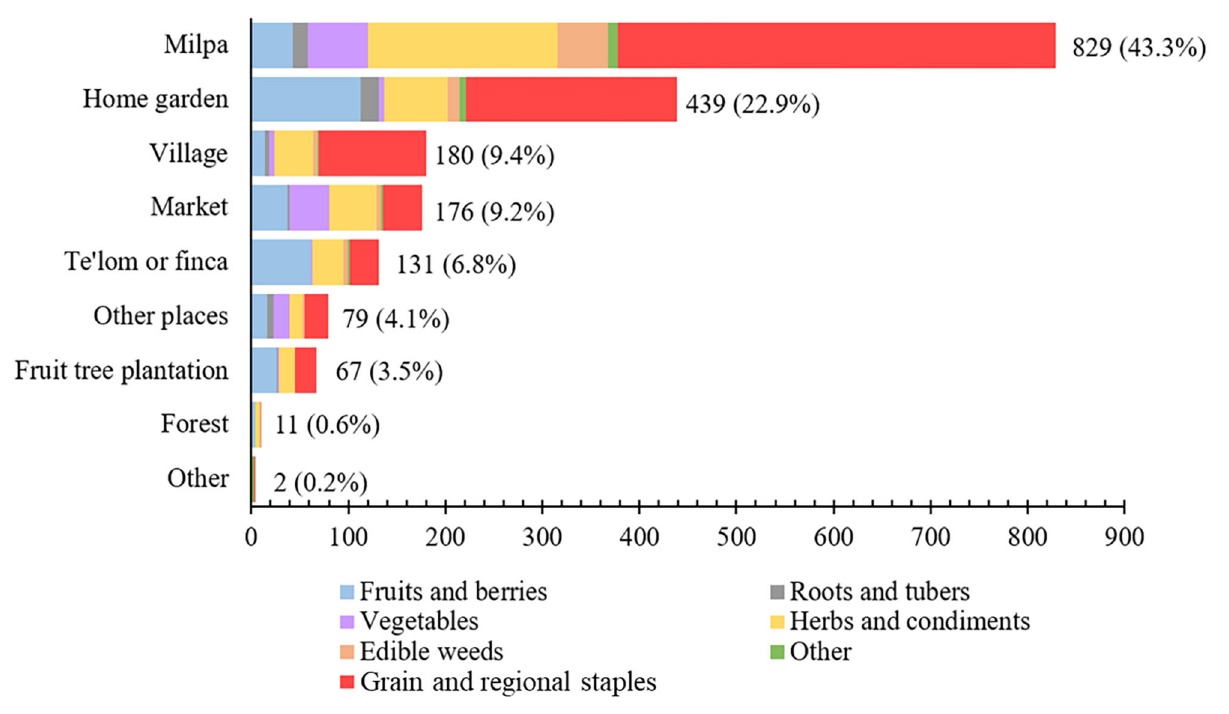
FIGURE 4 | Provenance of the products from local merchants in 10 rural markets in the Huasteca